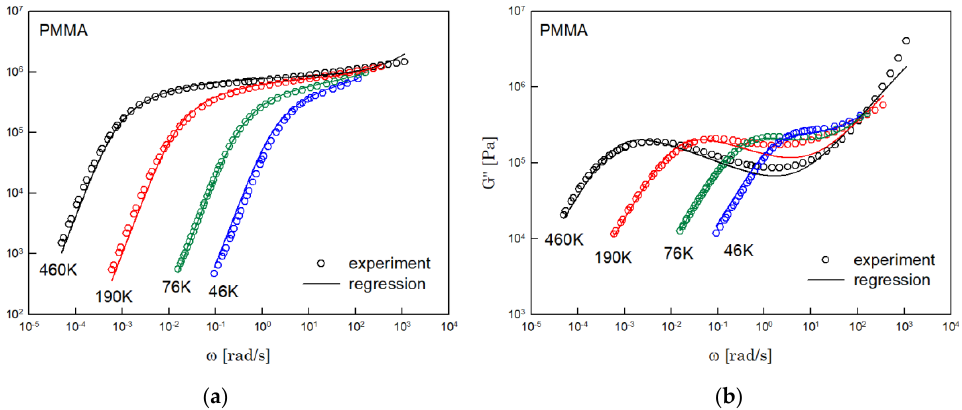
Figure 5. Comparison the regression results (lines) with the experimental data (symbols) of ( a ) storage modulus and ( b ) loss modulus of PI. These experimental data are measured by Person et al. [17].